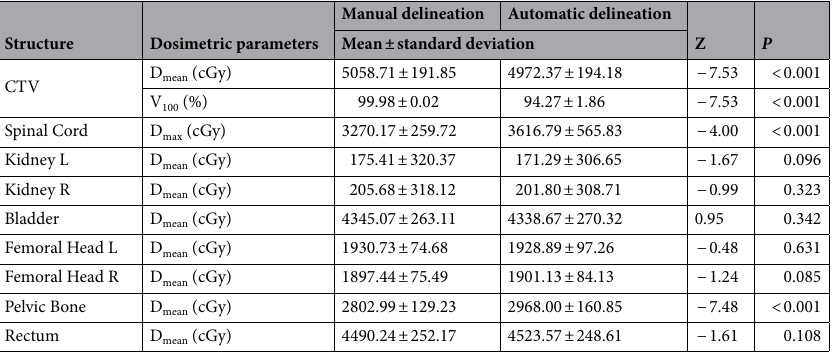
Table 2. Dosimetric metrics of manual and DL based auto-segmented delineations in the original clinical treatment plans.